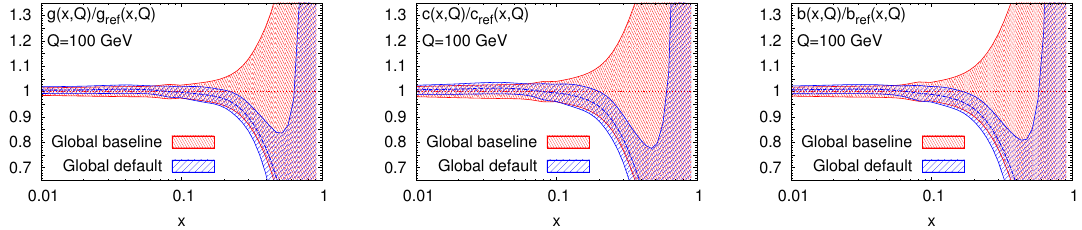
Figure 17 . The gluon, charm and bottom PDFs from the global baseline (cid:12)t compared to the optimal (cid:12)t including our optimal combination of LHC top-quark